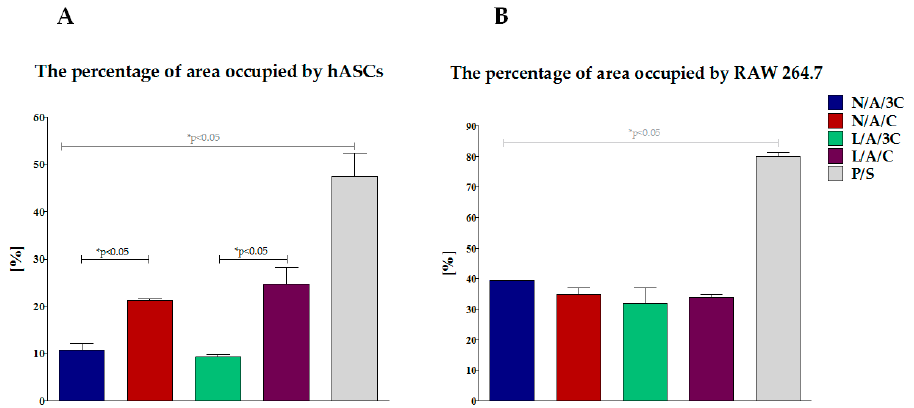
Figure 8. The percentage of area occupied by cells: ( A ) ASC; ( B ) RAW264.7. An asterisk (*) indicates a statistically significant difference ( p < 0.05).